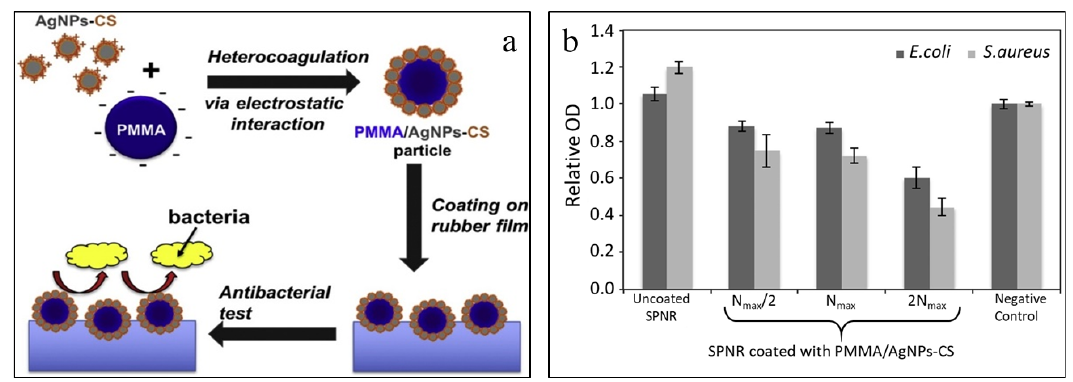
Figure 4. ( a ) Schematic illustration of polymethyl methacrylate/chitosan-silver (PMMA/AgNPs-CS) coating and its antibacterial activity; ( b ) optical density of suspension of Escherichia coli and coatinganditsantibacterialactivity; ( b )opticaldensityofsuspensionof Escherichiacoli and Staphylococcus Staphylococcus aureus . (Reprinted with permission from [56] Copyright (2019), Elsevier). aureus . (Reprinted with permission from [56] Copyright (2019),